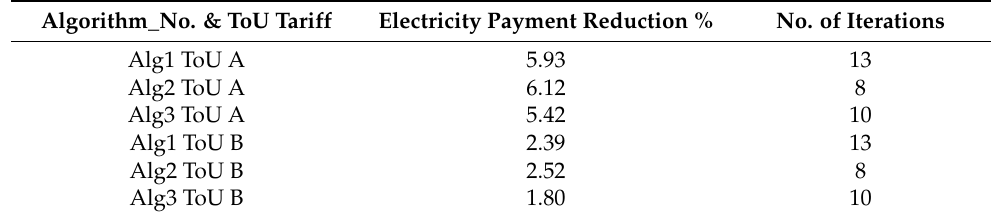
Table 4. Electricity payment reduction for different optimization algorithms and ToU